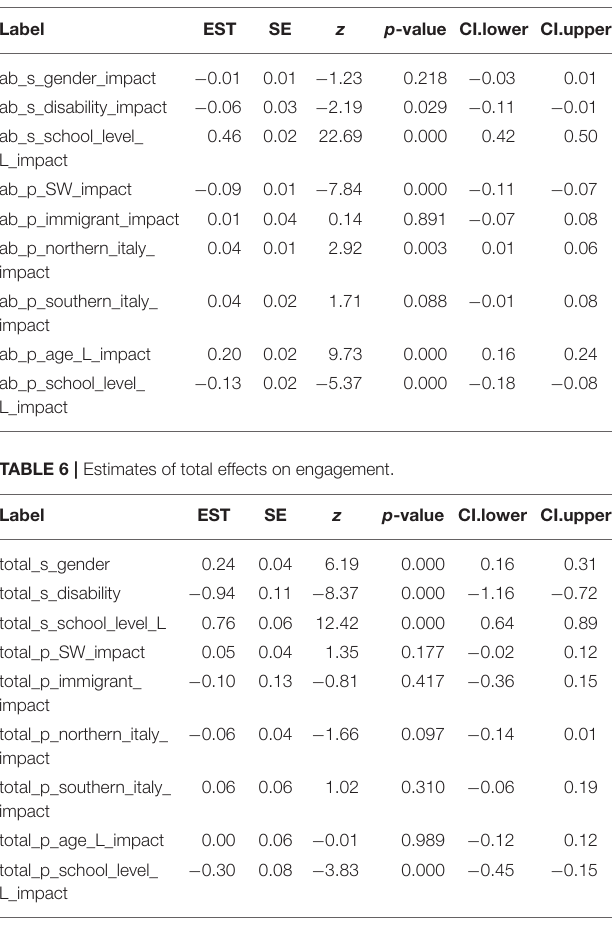
TABLE 5 | Estimates of indirect effects on engagement.